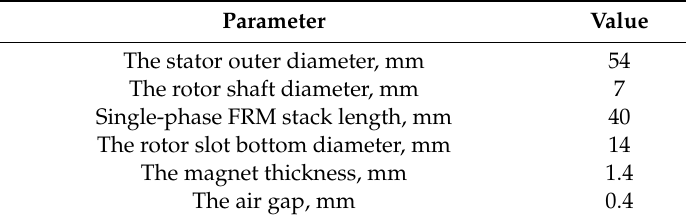
Table 2. Fixed geometrical parameters of the